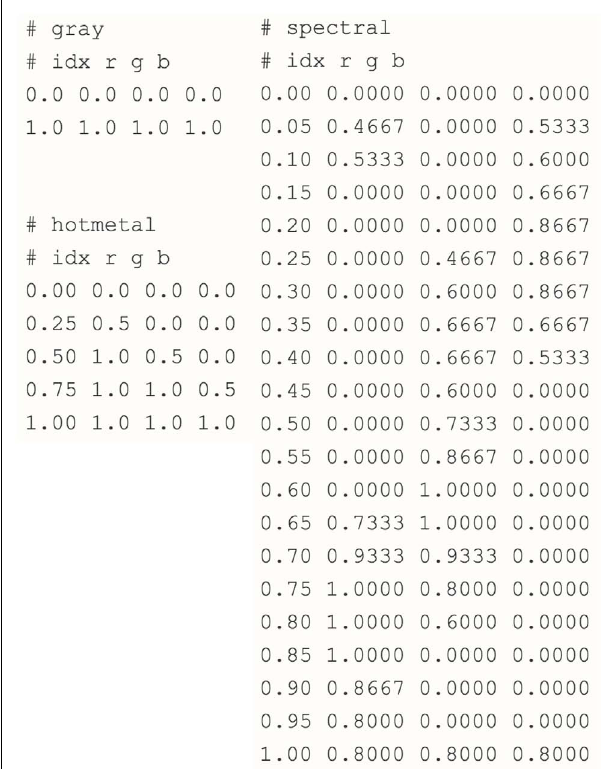
FIGURE 6 | Gray, Hot Metal, and Spectral color mapping aquarium .